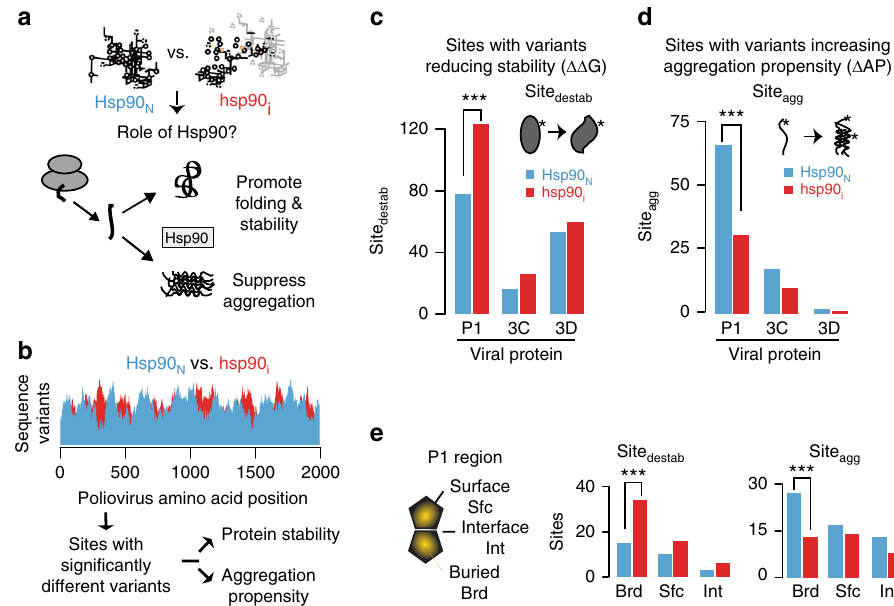
Fig. 3 Hsp90 in fl uences the capsid sequence space. a Role of Hsp90 in pathways of protein folding and aggregation. b Analysis pipeline to identify codon sites that differ signi fi cantly in their ability to support destabilizing variants (Site destab ) or aggregation-prone (Site agg ) variants between Hsp90 N and hsp90 i populations. Signi fi cant sites were identi fi ed as described in Methods. c , d Number of Site destab ( c ) and Site agg ( d ) observed in viral proteins: P1 capsid protein; 3C protease; and 3D polymerase. e Distribution of Site destab and Site agg at buried (Brd), interface (Int), or surface (Sfc) positions across folded P1 (based on crystal structure 2PLV). Signi fi cance: *** p < 0.005 by two-tail Fisher ’ s exact